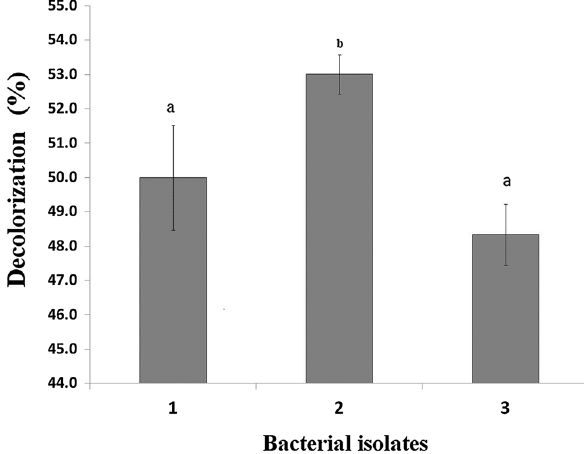
Fig. 1 Screening of bacterial isolates towards MB